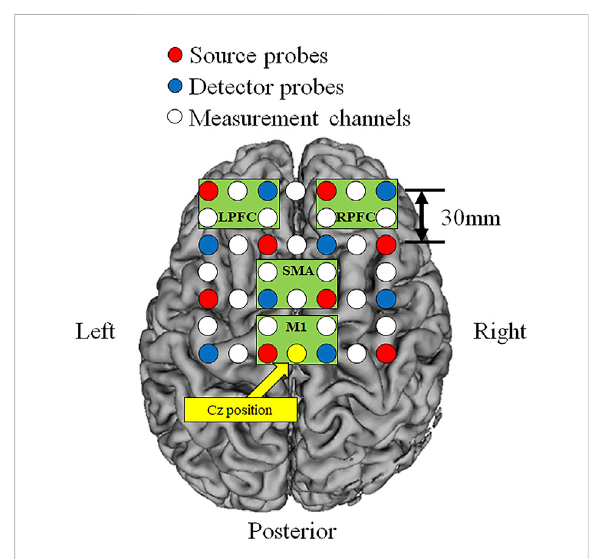
FIGURE 2 Locations of the source and detector probes and measurement channels. Red circles show source probes, blue circles show detector probes, white circles show measurement channels, and yellow circle show the vertex position (Cz). Green frames show measurement region of each cortex (L-PFC: left prefrontal cortex, R-PFC: right prefrontal cortex, SMA: supplementary motor area, M1: primary motor